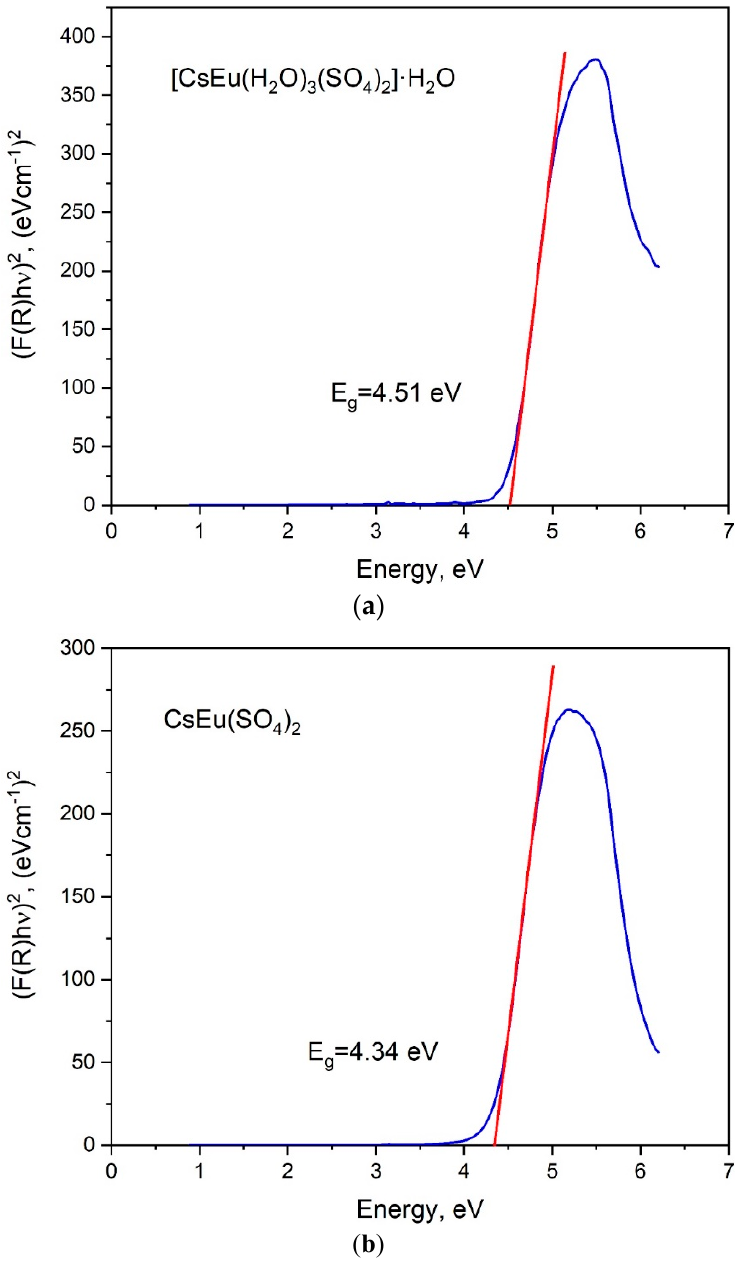
Figure 7. Tauc plots for ( a ) [CsEu(H 2 O) 3 (SO 4 ) 2 ]·H 2 O and ( b ) CsEu(SO 4 ) 2 .